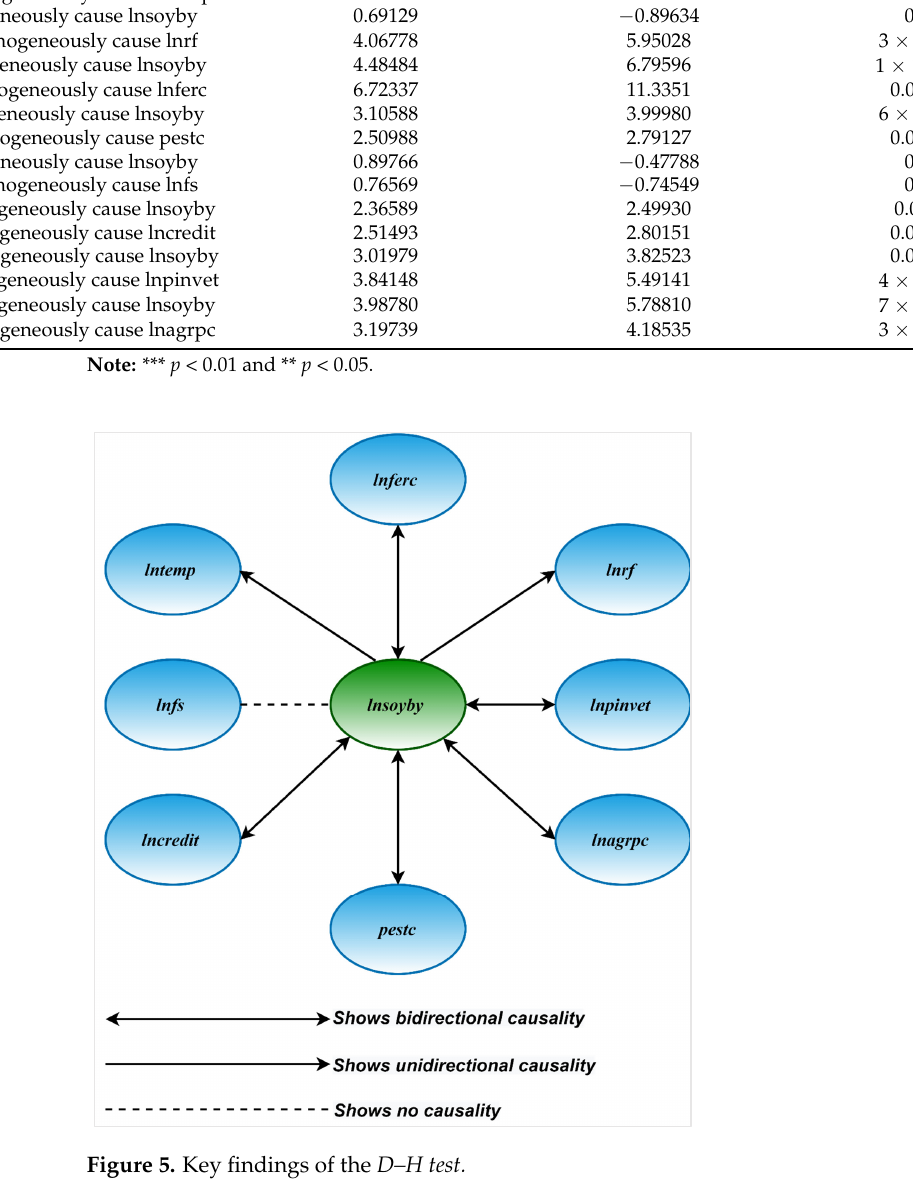
Table 7. D–H panel causality exploration.